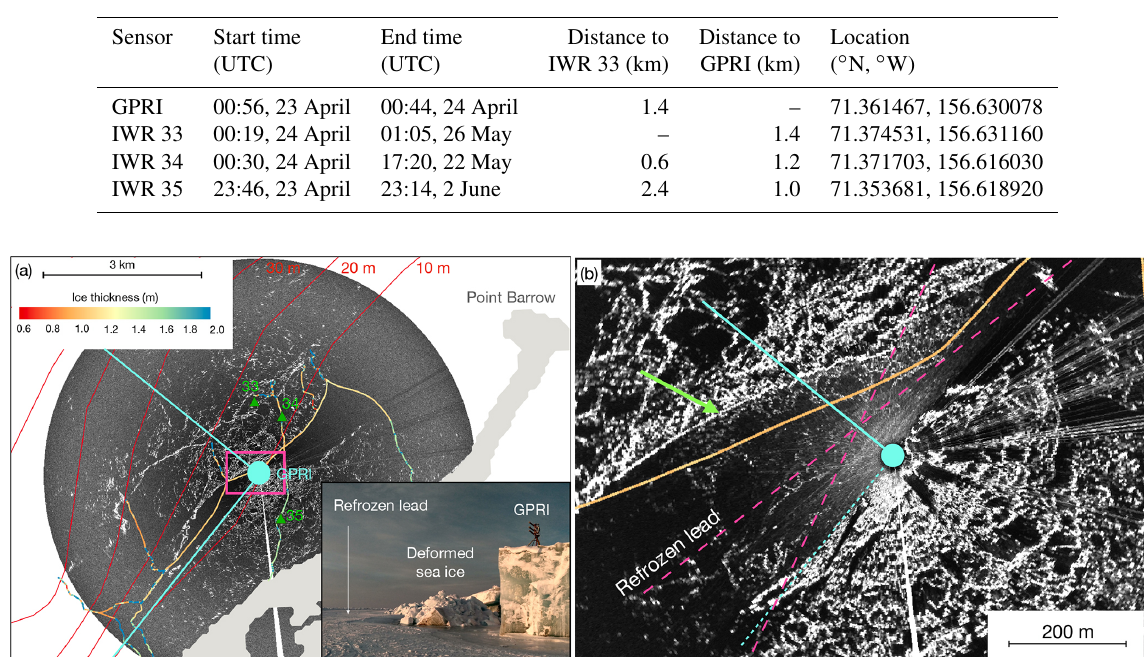
times higher powers of the wavenumber (see Johnson et